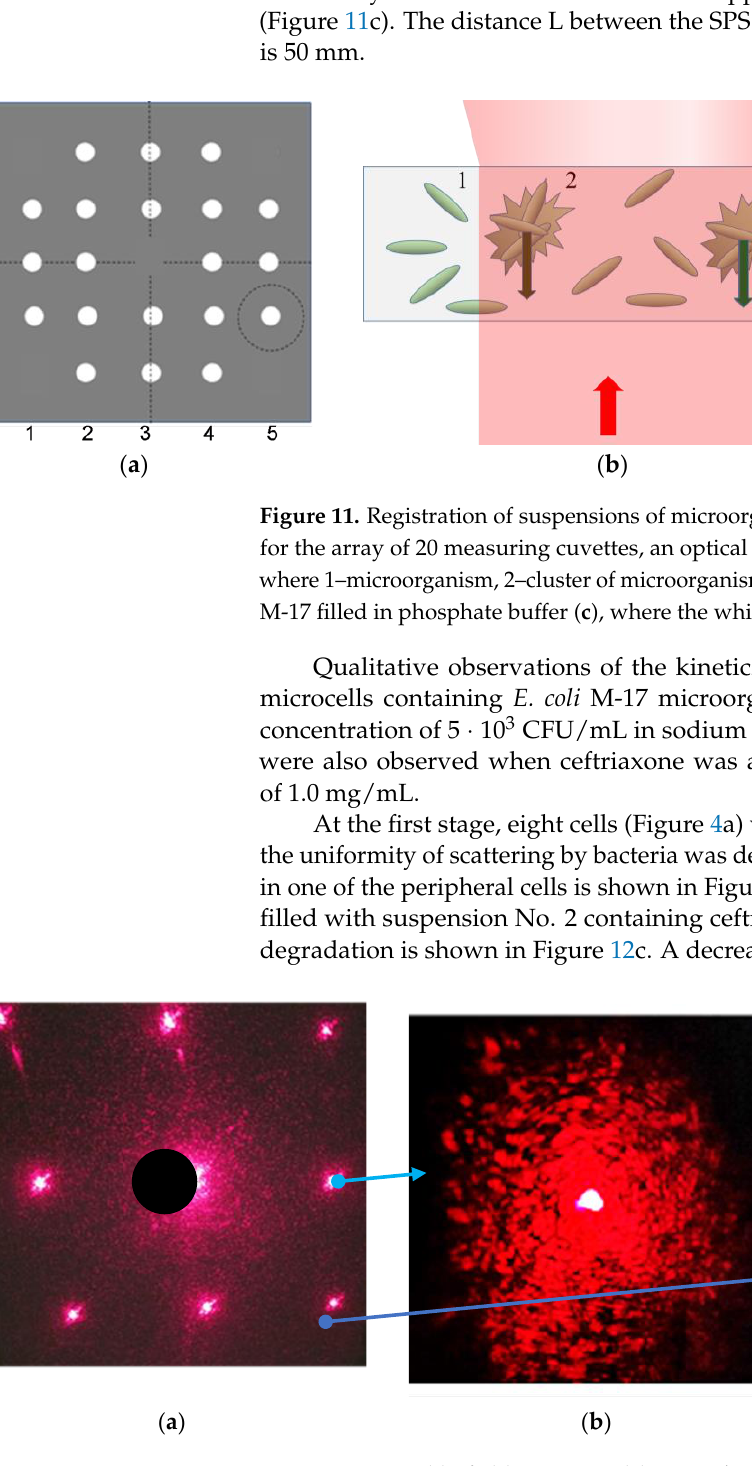
Figure 13. Time dependencies of scattering intensity fluctuations, I sp measured in the cell of planar multichannel chip (Figure 12) for the suspension of E. coli M-17, c = 10 8 CFU/mL (1) and the same with the addition of ceftriaxone (2) at the concentration of 1.0 mg/mL. 4. Conclusions Various modes of laser light scattering in the detection of the viability of microorgan- isms under exposure to antibiotics were investigated in order to select the format most